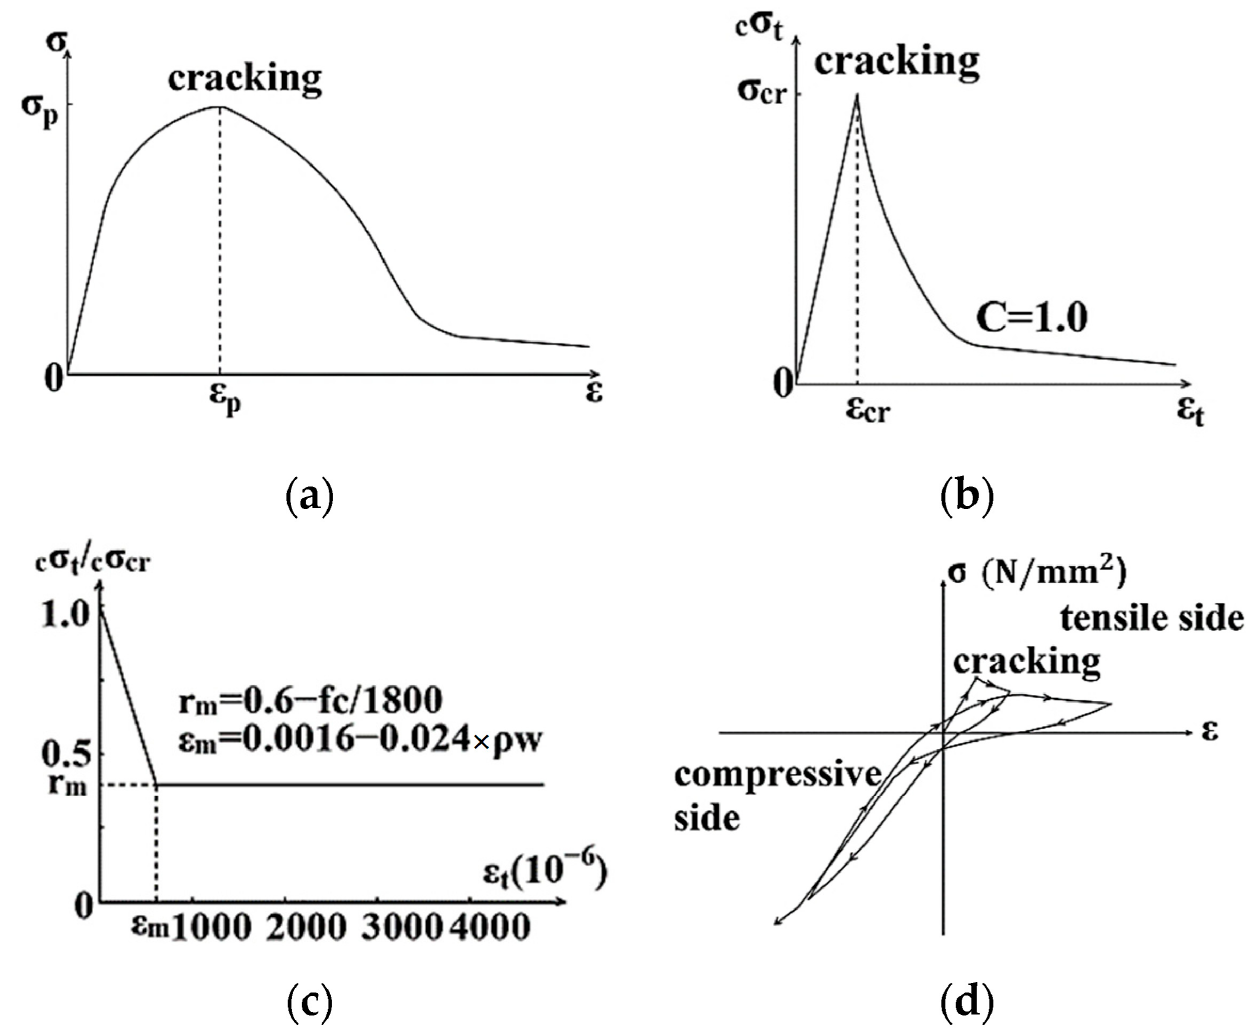
Figure 11. Concrete models: ( a ) “Naganuma-Yamakuchi” model, ( b ) Izumo model, ( c ) Modified Ahmad model, and ( d ) “Naganuma-Okubo”